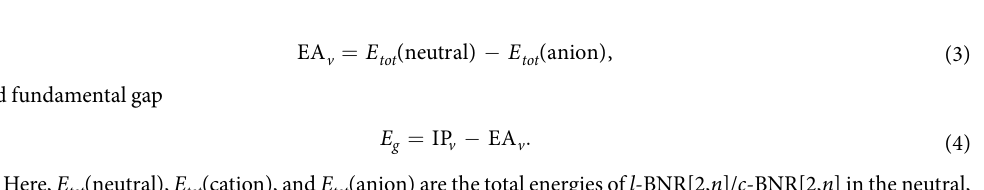
Figure 8. Visualization of the HOMO − 2 (1.815), HOMO − 1 (1.743), HOMO (1.089), LUMO (0.887), LUMO + 1 (0.348), and LUMO + 2 (0.106) for the ground state of l -BNR[2,30], obtained from spin-restricted TAO- LDA, at isovalue = 0.02 e/Å 3 . The orbital occupation numbers are shown in parentheses. Here, for simplicity, HOMO and LUMO are referred to as H and L,